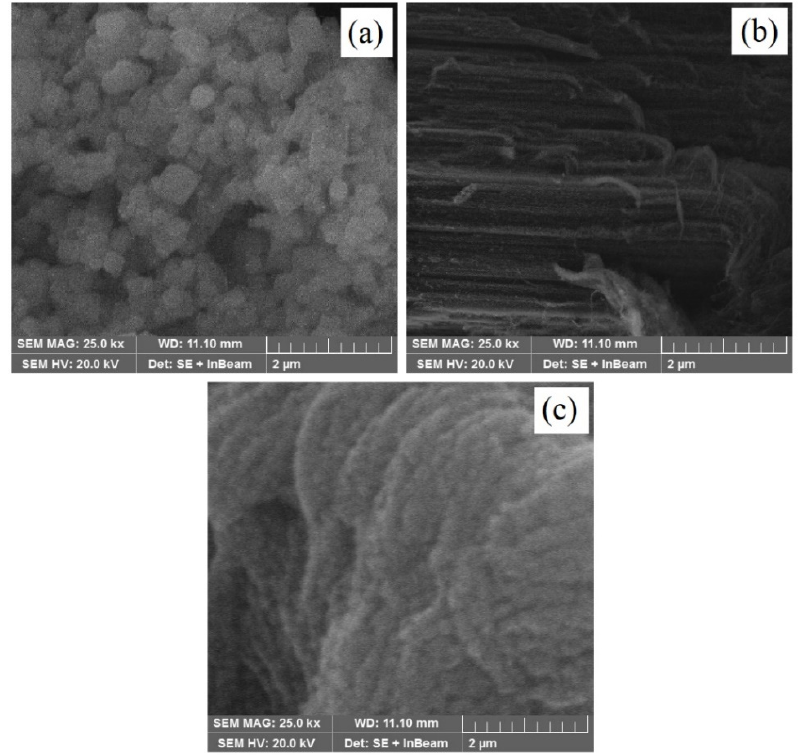
Figure 2. SEM micrographs of ( a ) ZnO nanoparticles, ( b ) Ti 3 C 2 with conventional 2D-layered structure and ( c ) ZnO/Ti 3 C 2